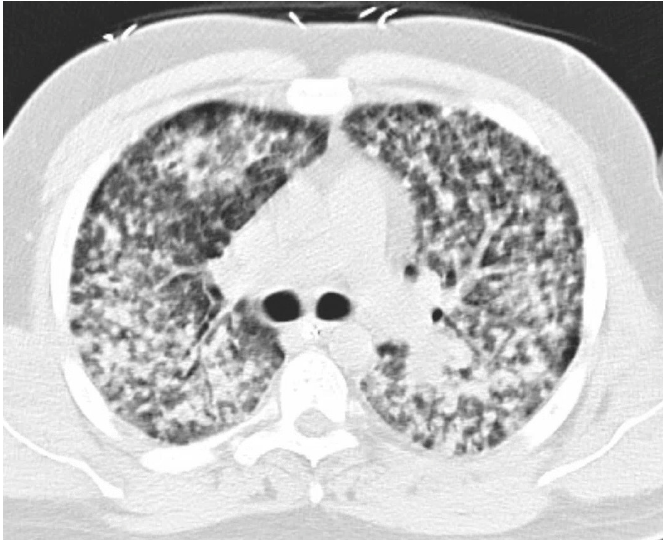
Image 1. Anteroposterior chest radiograph taken in the emergency department showing bilateral, diffuse pulmonary opacities consistent with the acute respiratory distress syndrome.